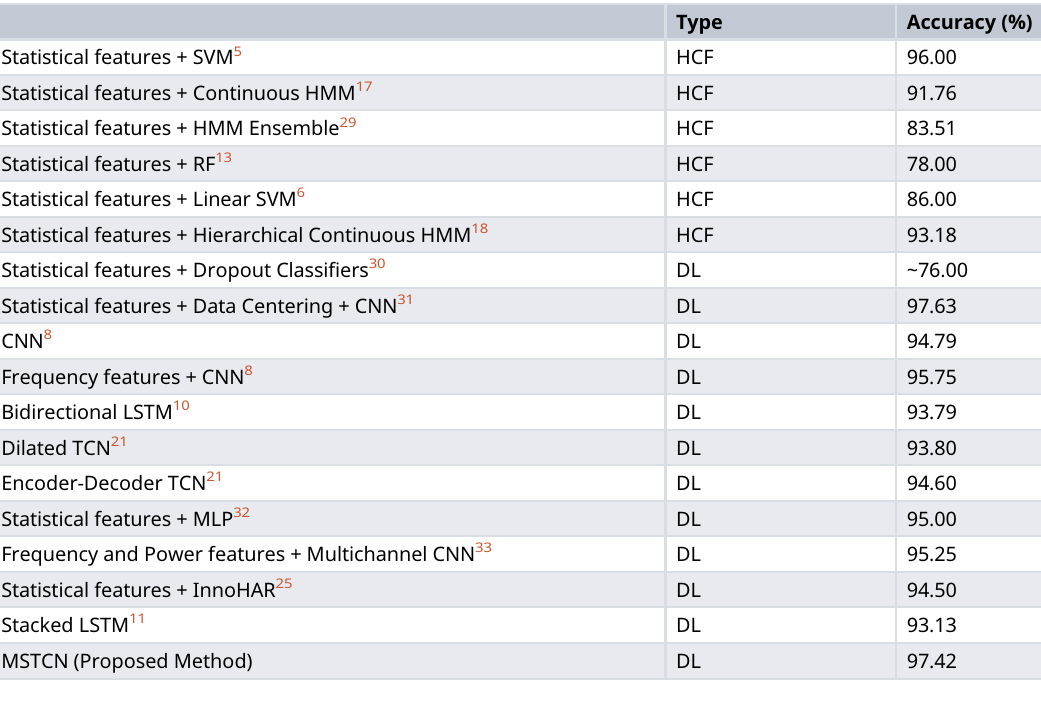
Table 6. Accuracy for user independent UCI dataset.